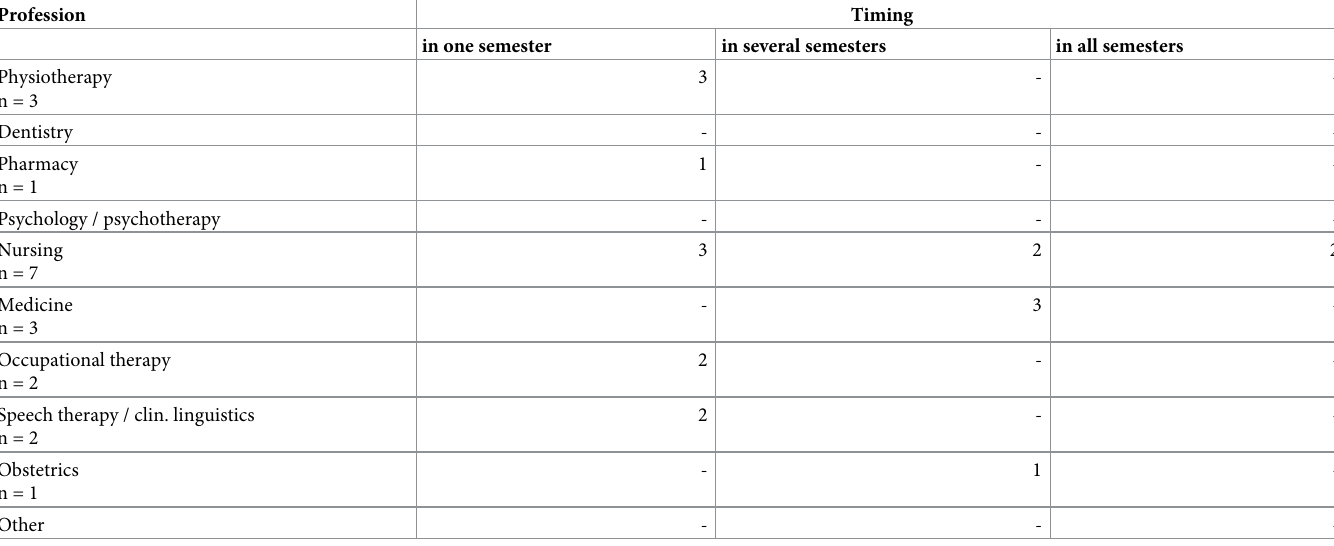
Table 3. Interprofessional PAL offers per profession and timing [multiple answer options, sample n = 11]. Profession